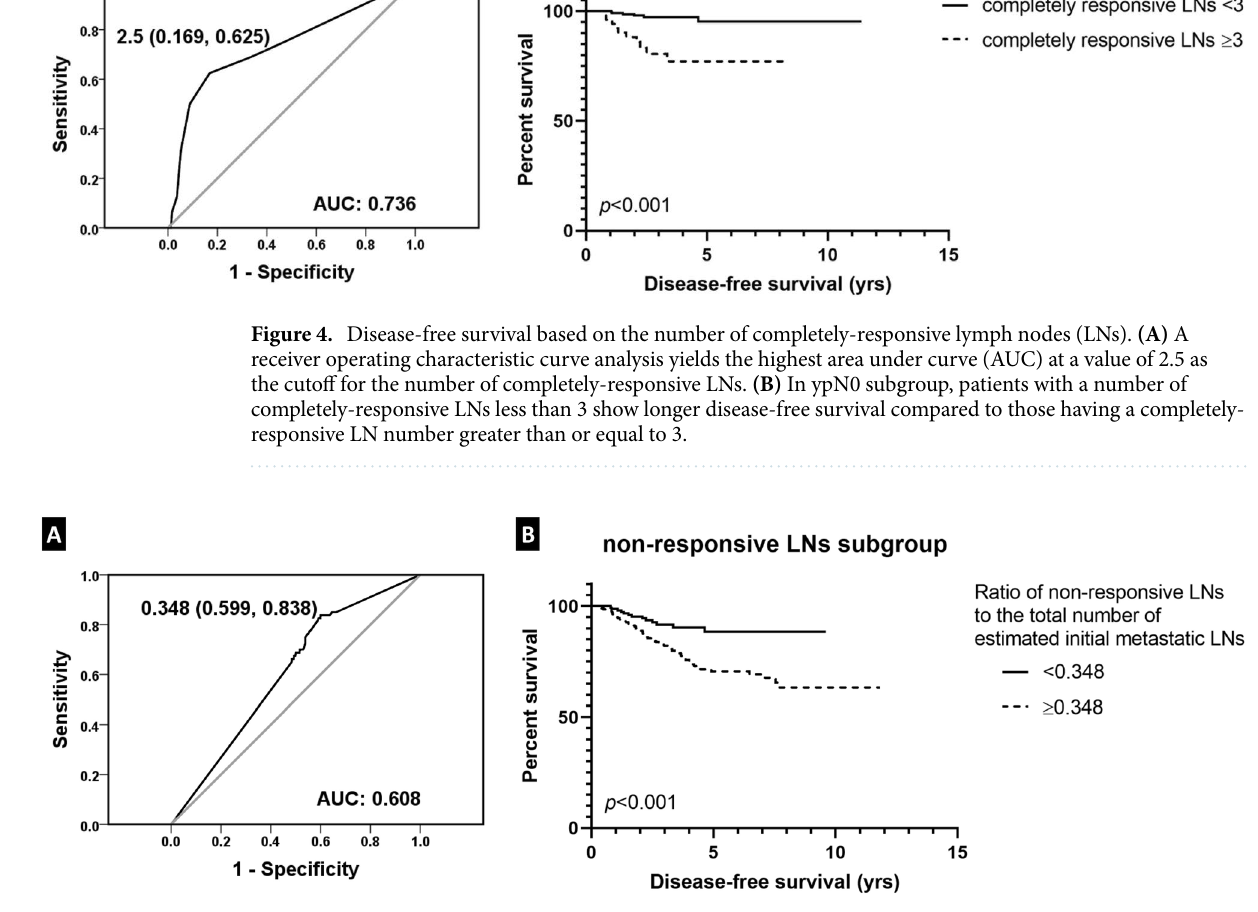
Figure 5. Disease-free survival based on the ratio of non-responsive lymph nodes (LNs) to the estimated total metastatic LNs. (A) A receiver operating characteristic curve analysis yields the highest area under curve (AUC) at a value of 0.348 as the cutoff for the ratio of non-responsive LNs to the estimated total initial metastatic LNs. (B) Patients with a ratio of non-responsive LNs to the total initial metastatic LNs less than 0.348 show a significantly longer disease-free survival compared to those with a ratio over